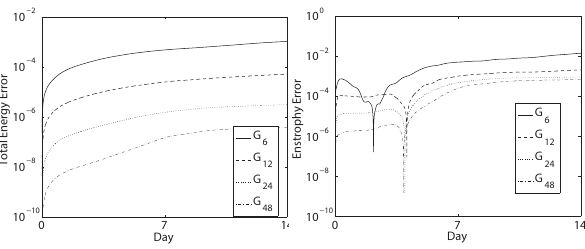
Figure 14. Normalized conservation errors of total energy and po- tential enstrophy on refined grids for case